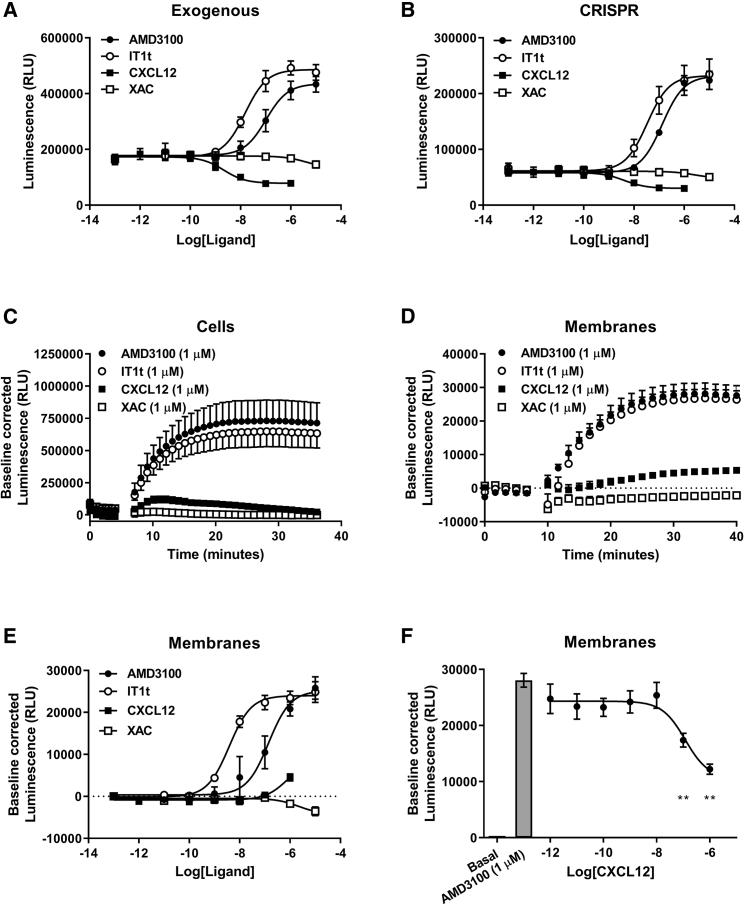
Using HiBiT-tagged CXCR4 to Investigate Cell Surface Expression and/or Conformational Changes(A–D) HEK293 cells expressing (A) exogenous or (B) genome-edited HiBiT/CXCR4 were incubated in the absence or presence of increasing concentrations of AMD3100 (black circles), IT1t (white circles), CXCL12 (black squares), or XAC (white squares) for 1 h at 37°C and luminescence measured 30 min following addition of purified LgBiT (10 nM) and furimazine (10 μM). Kinetic analysis of the change in luminescence mediated by addition of AMD3100 (1 μM, black circles), IT1t (1 μM, white circles), CXCL12 (1 μM, black squares), or XAC (1 μM, white squares) in (C) HEK293 cells expressing genome-edited HiBiT/CXCR4 or (D) using membrane preparations from HEK293 cells exogenously expressing HiBiT/CXCR4, both pre-incubated with 10 nM purified LgBiT.(E) AMD3100 (black circles), IT1t (white circles), CXCL12 (black squares), or XAC (white squares) concentration-response curves using membrane preparations from HEK293 cells exogenously expressing HiBiT/CXCR4 complemented with LgBiT.(F) Concentration-dependent inhibition of the AMD3100-mediated increase in luminescence by CXCL12 using membrane preparations from HEK293 cells exogenously expressing HiBiT/CXCR4 complemented with LgbiT and pre-incubated with 10 nM purified LgBiT. Points represent mean ± SEM of four (D), five (A, B, and, E), six (C), or eight (F) experiments performed in triplicate.Baseline-corrected luminescence calculated as described in the STAR Methods. **p < 0.01. Statistical analysis by one-way ANOVA with a Dunnett's multiple comparisons test (see Figures S5 and S6).